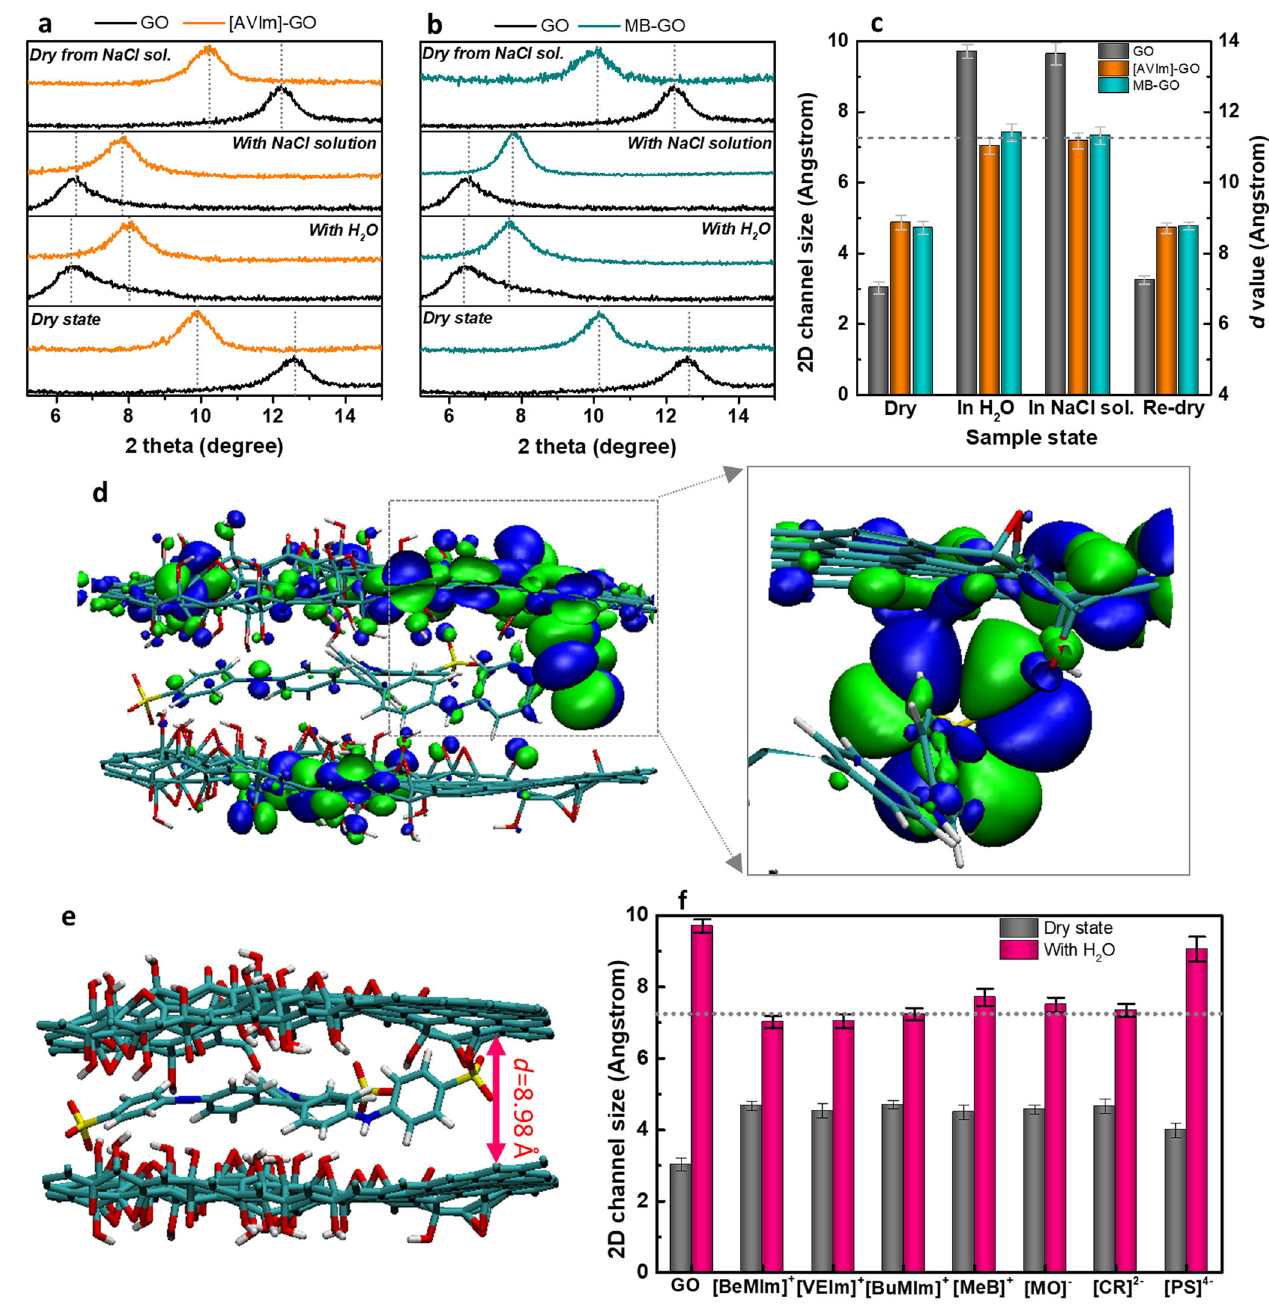
Fig. 2 Ion-intercalation effects on GO membranes. XRD patterns of a [AVlm]-GO and b MB-GO membranes in dry, wet, NaCl solution-treated and re-dry states. c The 2D channel sizes of GO, [AVlm]-GO, and MB-GO membranes in dry, wet, NaCl solution-treated and redried states. The dashed line represents the size of hydrated Na + ions i.e., 7.2 Å. d The occupied states of the molecular orbitals (HOMO-1) of the MB-GO structure (The electron density is plotted for iso-values of ±0.005 atomic units with green and blue denoting opposite signs) and e Side view of optimized MB-GO structure (C, cyan; H, white; O, red; N, blue; P, yellow). f The effects of ion type on the control of 2D channel size of GO membranes. The error bars in ( c ) and ( f ) are the standard error of the mean